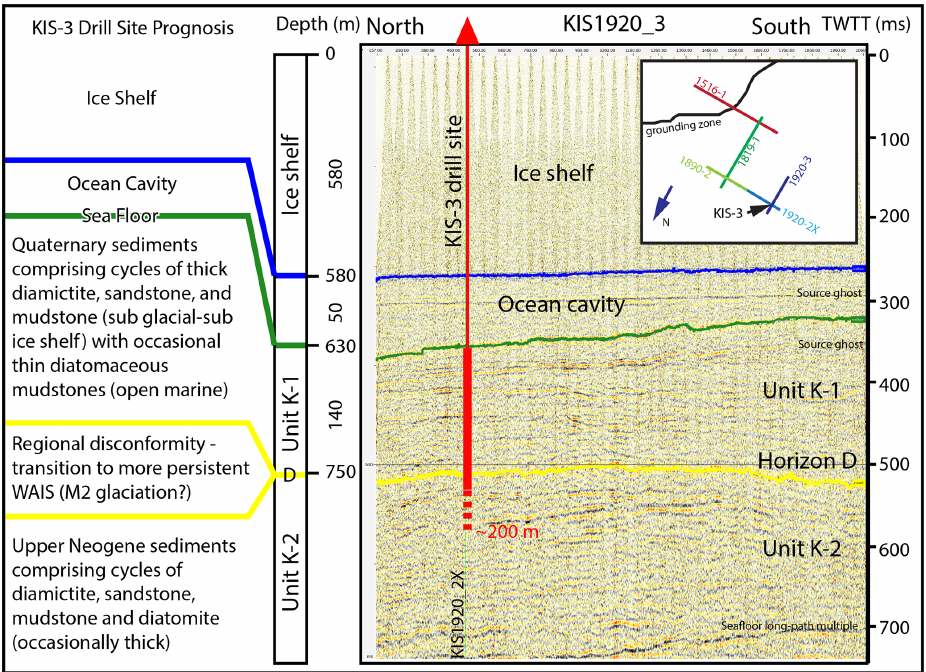
Figure 2. Seismic line KIS 1920_3. The KIS-3 drill site is located on the crossing point with line KIS1920_2X (inset). Drilling prognosis on the left with estimated depths from the surface and a brief description of stratigraphic intervals and horizons. The thick red line shows the 200m drilling target